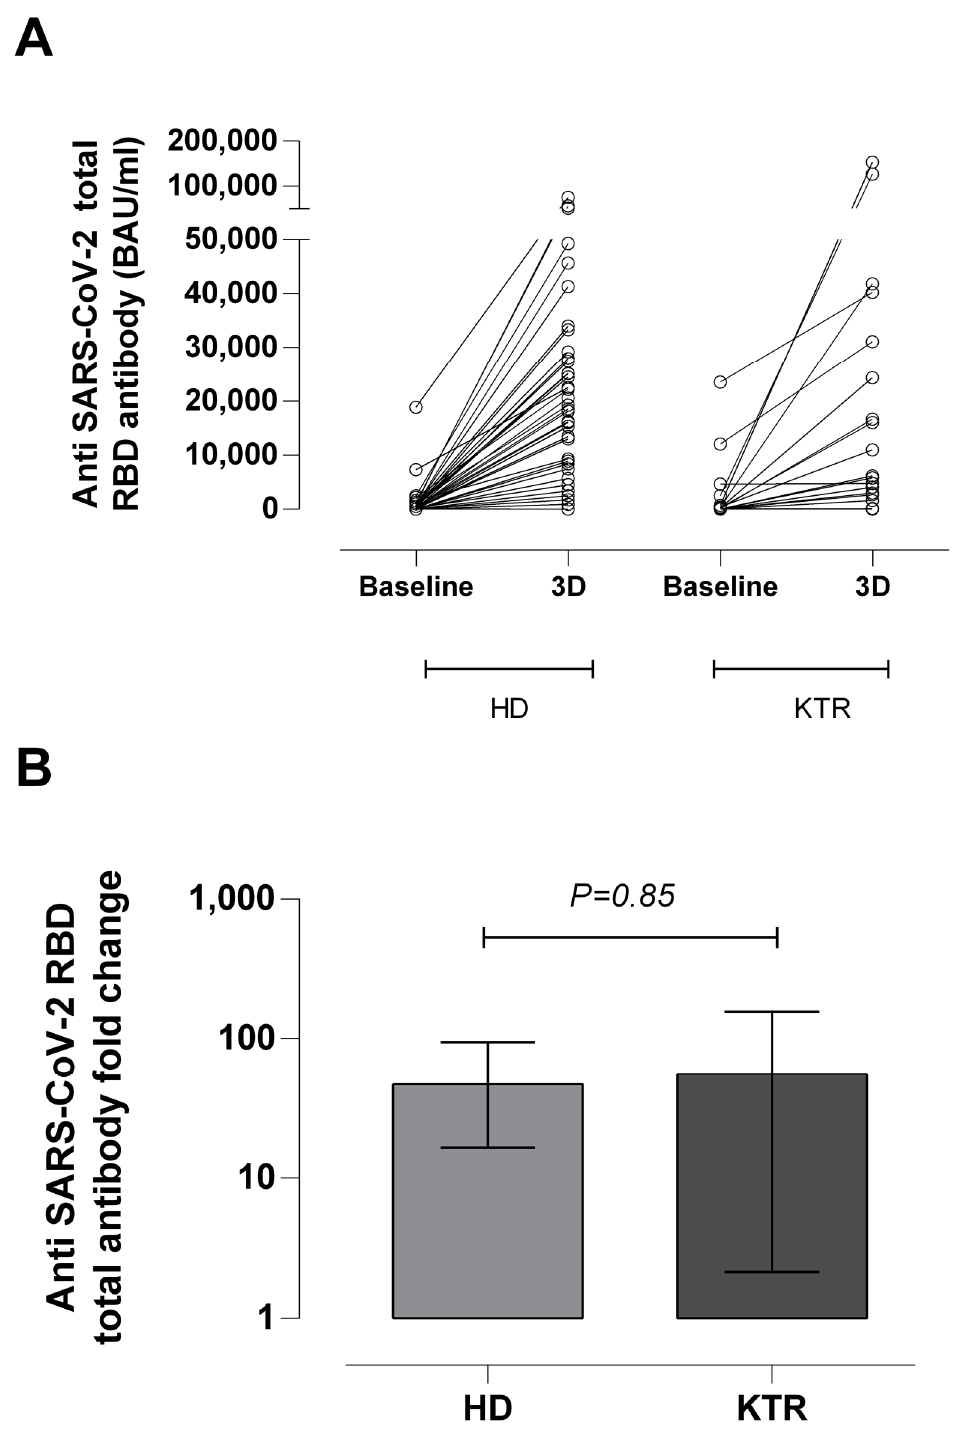
Figure 1. Receptor binding domain (RBD)-reactive total antibodies (in BAU/mL) in hemodialysis patients (HD) and kidney transplant recipients (KTR) after receipt of a homologous mRNA COVID-19 third dose (3D). ( A ) Baseline and 3D antibody levels of participants are shown individually. ( B ) Box and whisker plot depicting the fold-change in anti-RBD antibody levels following 3D in HD and KTR patients. The p -value for comparison across groups is shown.